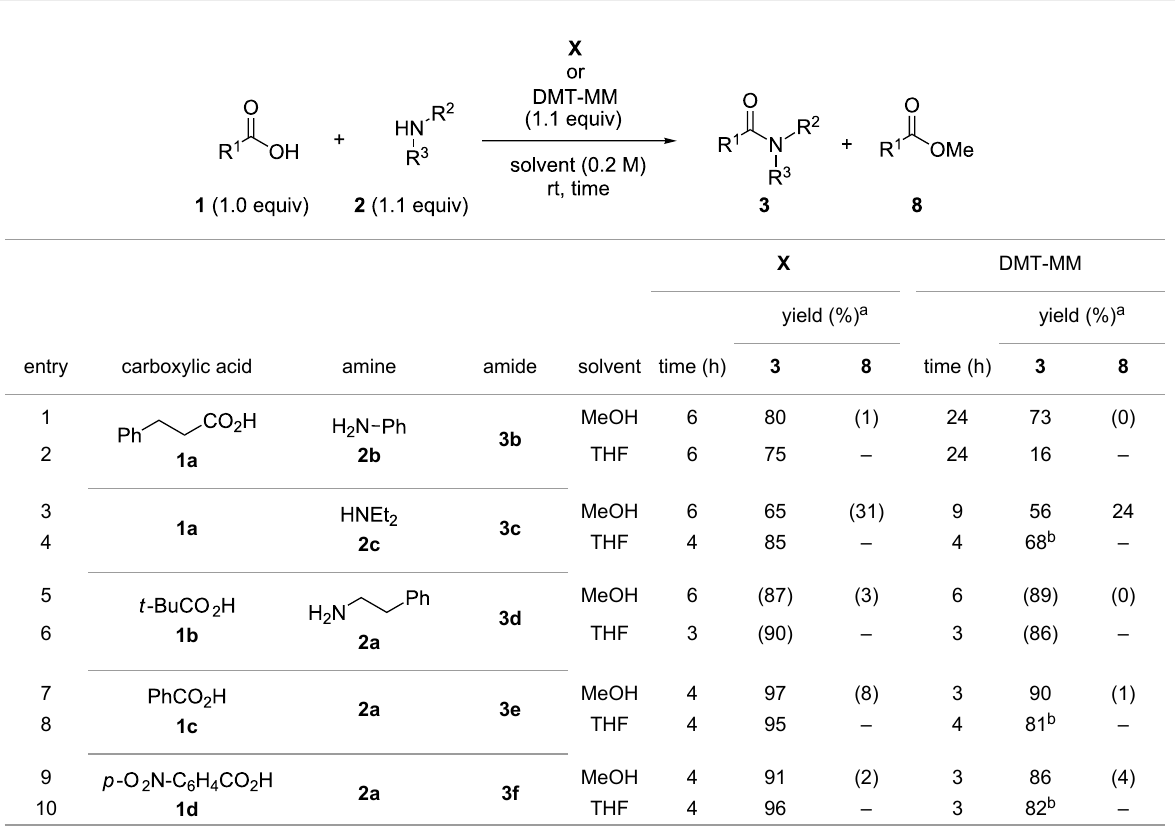
Table 2: Substrate scope of carboxylic acids 1 and amines 2